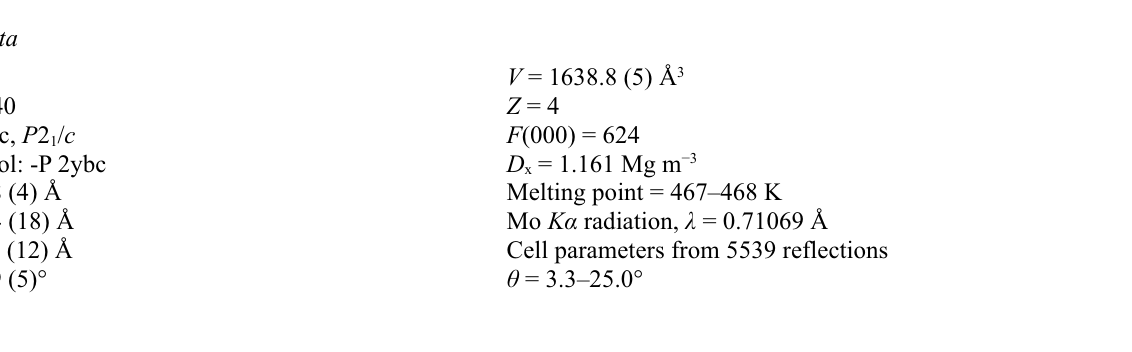
Molecular packing and hydrogen bonding as viewed down [001]. Dashed lines represent hydrogen bonds. Most H atoms not involved in hydrogen bonding have been omitted to improve clarity. [Symmetry code: (i) - x + 1, - y + 1, - z + 1.] ( RS )-4-(4- tert -butylphenyl)-2,6-dimethylcyclohex-3-enecarboxylic